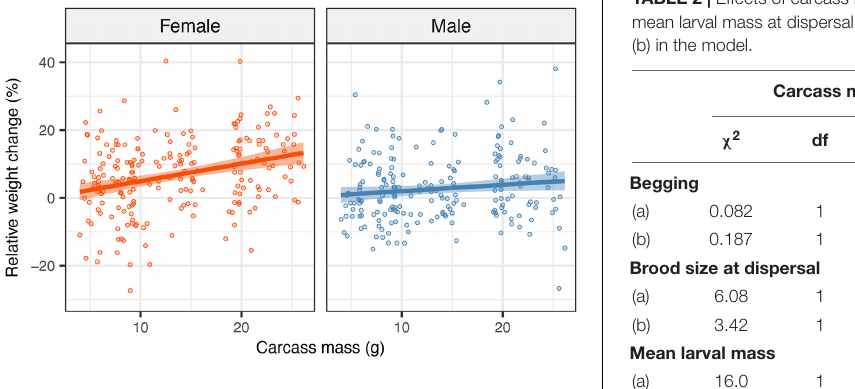
FIGURE 2 | Effects of carcass mass on the weight change of each parent. Filled circles represent individual data points; lines represent linear regression lines and shaded ribbons the 95% confidence intervals.